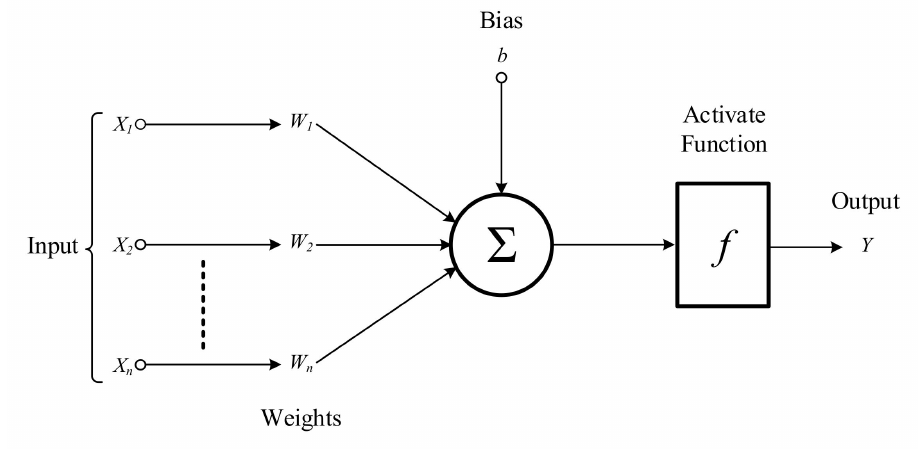
Figure 3. Concept of